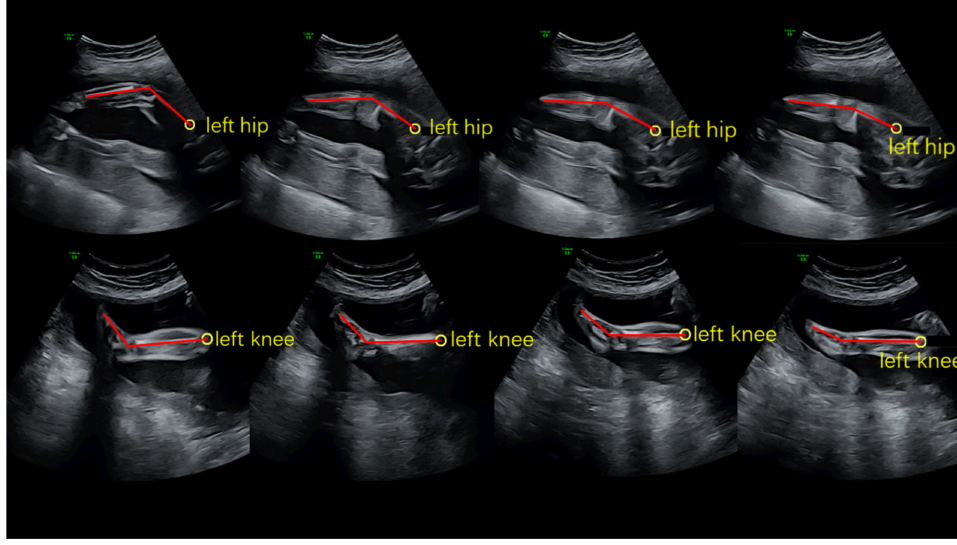
Figure 1. Keyframes during simi motion